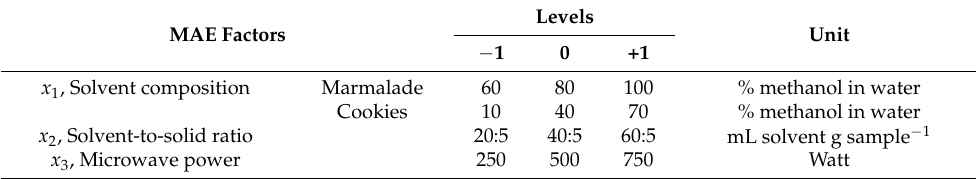
Table 2. Coding table of experimental factors and levels in microwave-assisted